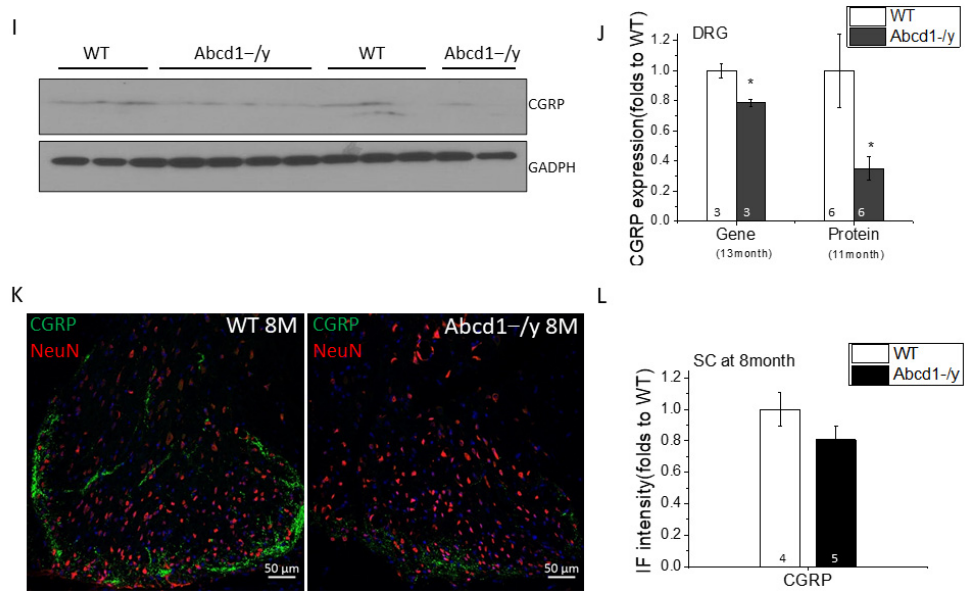
Figure 4. Dorsal root ganglia of Abcd1 − /y mice reveal an increase in IB4-positive mechanical no- ciceptors. ( A ) Representative confocal images showing NF (red) and peripherin (green) staining in 1-month-old mouse DRG. Bar= 50 µ m. ( B ) NF-positive and peripherin-positive neurons were quantified by image J in 1-month-old mouse DRG ( n = 5 for WT and n = 6 for Abcd1 − /y ). ( C ) Rep- resentative confocal images showing NF (red) and peripherin (green) staining in 13-month-old DRG. Bar = 100 µ m. ( D ) NF-positive and peripherin-positive neurons were quantified by image J in 13-month-old mouse DRG ( n = 4 for WT and n = 4 for Abcd1 − /y . ( E ) Representative confocal images showing CGRP (red) and IB4-conjugate (green) staining in 1-month-old mouse DRG. ( F ) CGRP- positive and IB4-positive neurons were quantified by image J in 1-month-old mouse DRG ( n = 7 for WT and n = 5 for Abcd1 − /y ). ( G ) Representative confocal images showing CGRP (Red) and IB4-conjugate (green) staining in 11-month-old mouse DRG. ( H ) CGRP-positive and IB4-positive neurons were quantified by image J in 11-month-old mouse DRG ( n = 5 for WT and n = 3 for Abcd1 − /y ). ( I ) Western blot images showing CGRP expression in Abcd1 − /y DRG ( n = 6 for each). ( J ) Quantification of CGRP gene and protein expression in Abcd1 − /y DRG. ( K ) Representative confocal images showing NeuN (red) and CGRP (green) staining in 8-month-old mouse spinal cord dorsal horn. ( L ) Quantification of CGRP immunostaining intensity in spinal cord dorsal horn ( n = 4 for WT and n = 5 for Abcd1 − /y ). Results were expressed as means ±SEM. * p < 0.05 as compared with WT control.